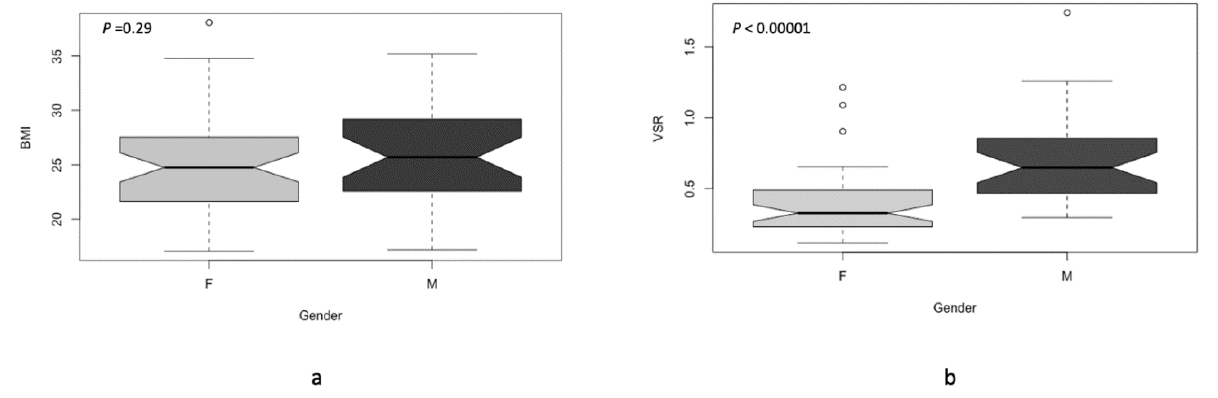
Figure 2. ( a ) Boxplot diagram showing BMI in both males “M” and females “F” and diagram Figure 2. ( a ) B oxplot diagram showing BMI in both males “M” and females “F” and dia- ( b ) showing VSR in males “M” and females “F”. gram ( b ) showing VSR in males “M” and females “F”.